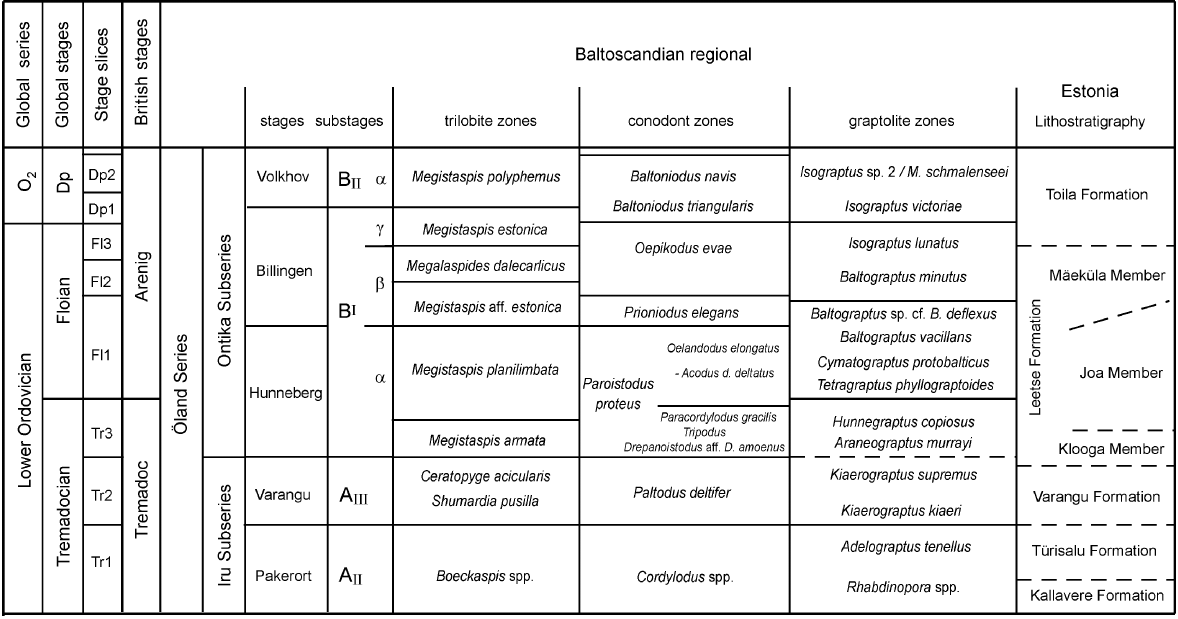
Fig. 1. Stratigraphic classification with biostratigraphical subdivision of the Lower Ordovician in Baltoscandia, modified from P(cid:228)rnaste (2006a; see discussion and references there) and P(cid:228)rnaste et al. (2012), with refreshed graptolite data by Maletz & Ahlberg (2011), conodont data by Viira (2011), and following the revised global standard (Bergstr(cid:246)m et al.